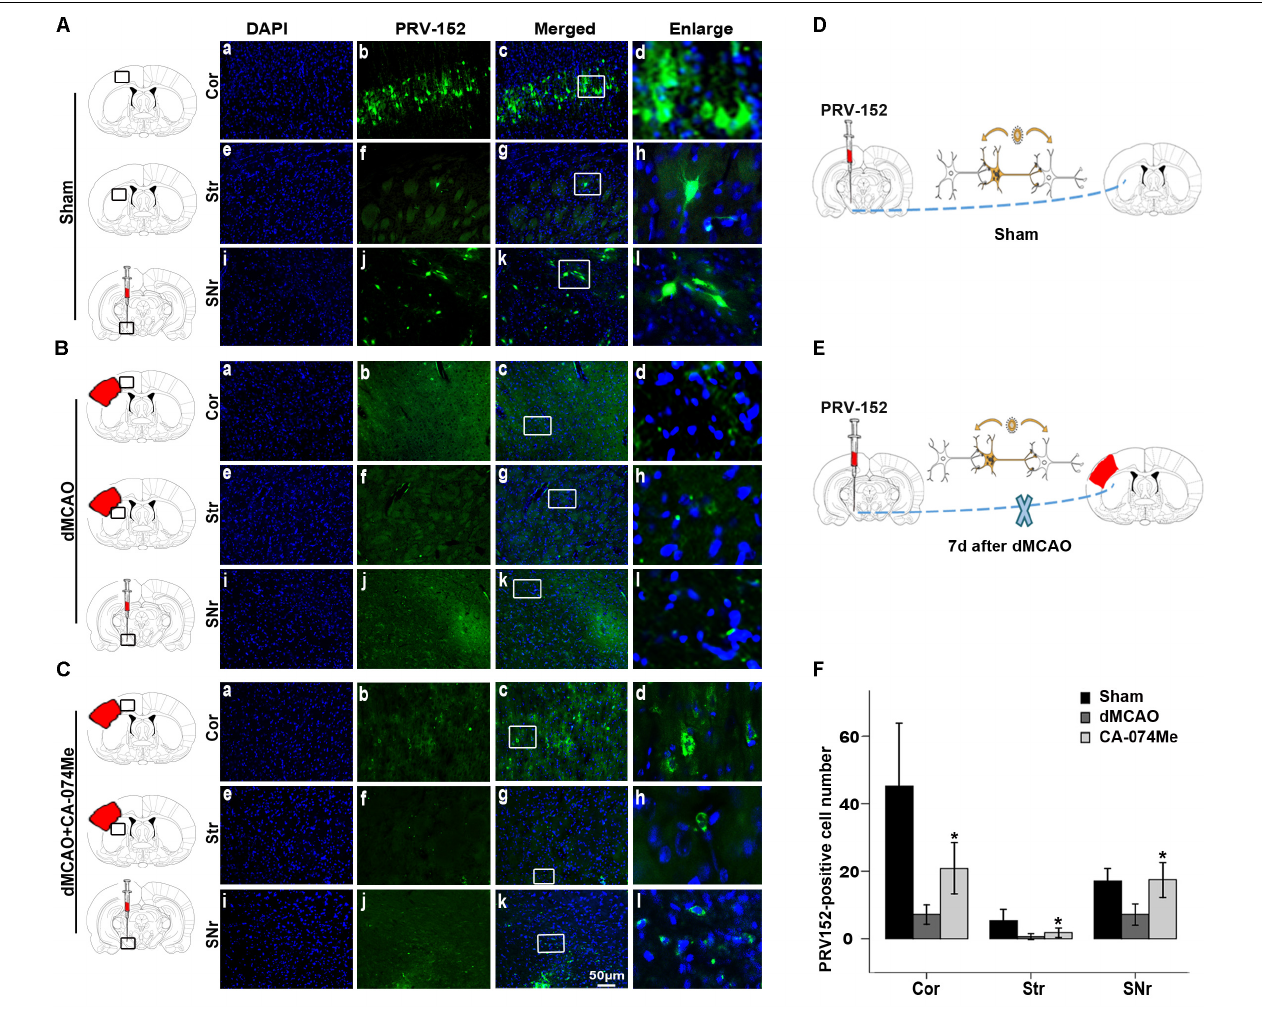
FIGURE 7 | Cortico-striatum-nigral tract tracing with PRV-152. (A) Photographs showed that PRV-152 (green) was injected into the ipsilateral SNr (i–l) and its signals were observed in the pyramidal neurons in the ipsilateral frontal and parietal cortex (a–d) and striatum (e–h) at 4 days after injection in sham-operated group ( n = 6). (B) Photographs showed that PRV-152 (green) was injected into the ipsilateral SNr (i–l) and its signals were observed in the pyramidal neurons in the ipsilateral frontal and parietal cortex (a–d) and striatum (e–h) at 4 days after injection in dMCAO group ( n = 7). (C) Photographs showed that PRV-152 (green) was injected into the ipsilateral SNr (i–l) and its signals were observed in the pyramidal neurons in the ipsilateral frontal and parietal cortex (a–d) and striatum (e–h) at 4 days after injection in CA-074Me group ( n = 7). Scale bar, 50 µ m. (D–E) Schematic illustration of the fluorescent signal of PRV-152 in sham-operated group and dMCAO group after PRV-152 was injected into the ipsilateral SNr. (F) Quantitative analysis of PRV152-positive cell number in the cortex, striatum, and SNr after dMCAO. Each bar represents the mean ± SD. ∗ p < 0.05 versus the dMCAO animals. Cor, cotrex; Str, striatum; SNr, substantia nigra pars reticulata; Sham; sham-operated; d,